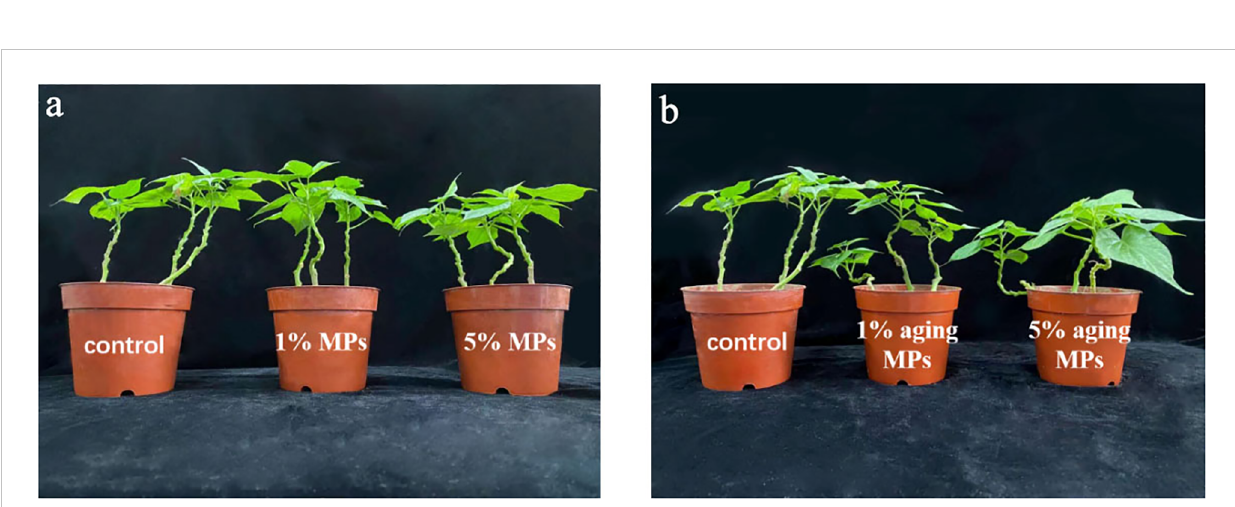
FIGURE 4 Growth of sweet potatoes planting in PE MPs and Cd compound-contaminated soil. Plant samples are collected after been treated by original (A) or weathered (B) PE MPs (0, 1% and 5%) for 15 days. Different letters in each fi gure indicate signi fi cant (p < 0.05) differences according to Tukey ’ s test.